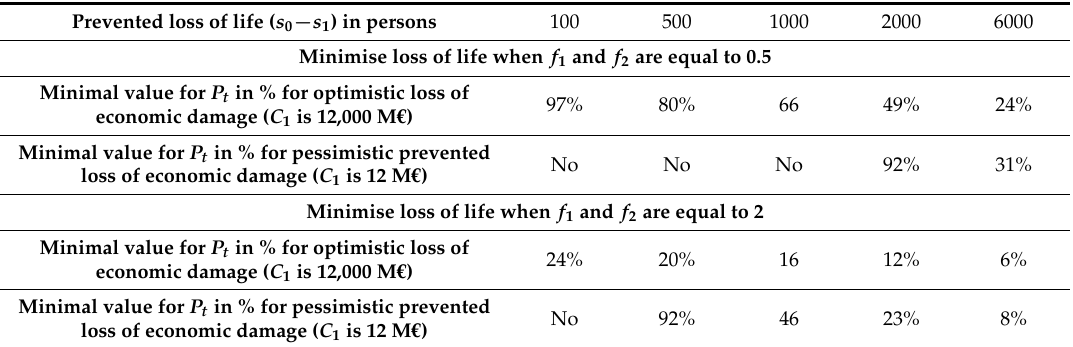
Table 2. Sensitivity analysis for numerical examples for the objective of minimising the economic costs, including the value of the loss of